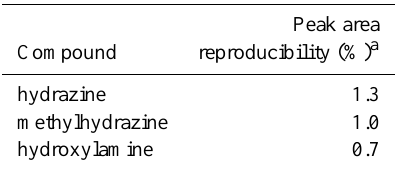
Table 3. Reproducibility of the Activated Primary Amine Derivati- zation Method.